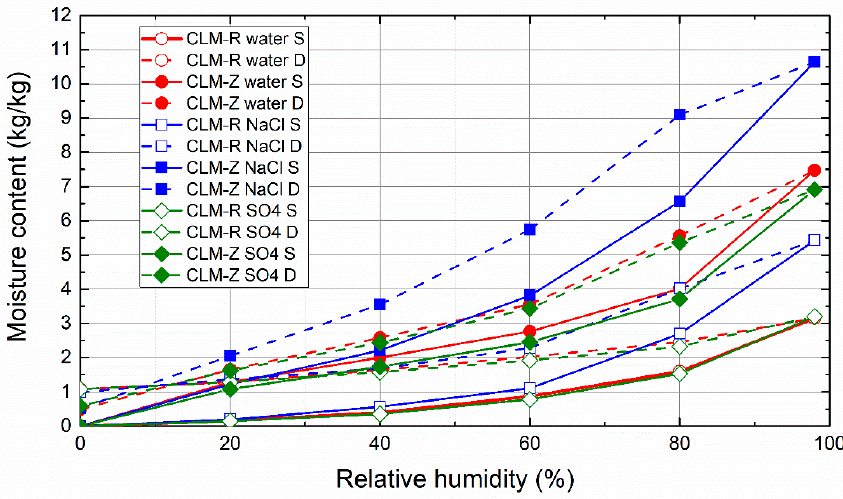
Figure 11. Sorption and desorption isotherms of cement-lime mortars (CLM).